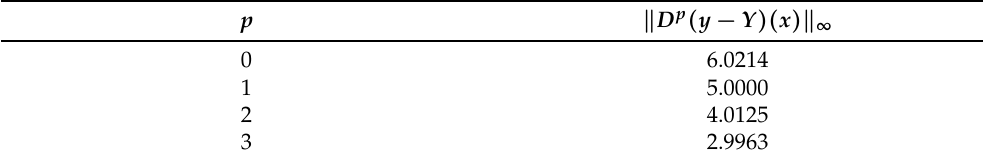
Table 2. Global convergence rates for Example